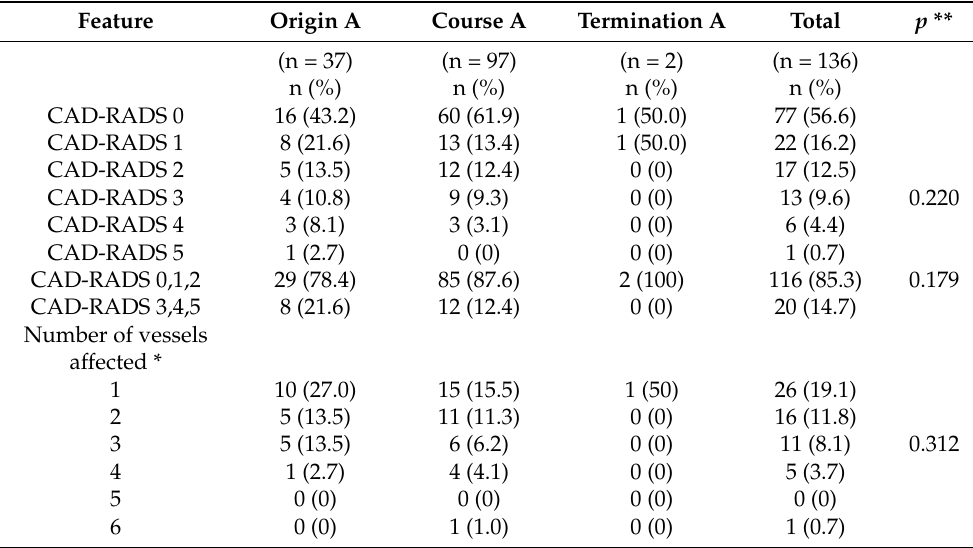
Table 4. The patients ’ CAD-RADS scores and the number of affected vessels in terms of coronary artery disease.